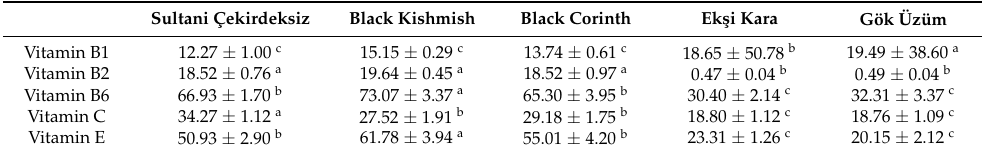
Table 5. Vitamin contents (mg 100 g − 1 of dry weight) of two stenospermocarpy varieties (Sultani Çekirdeksiz and Black Kishmish); one parthenocarpic variety (Black Corinth) and two seeded varieties (Ek¸si Kara and Gök Üzüm) in 2020